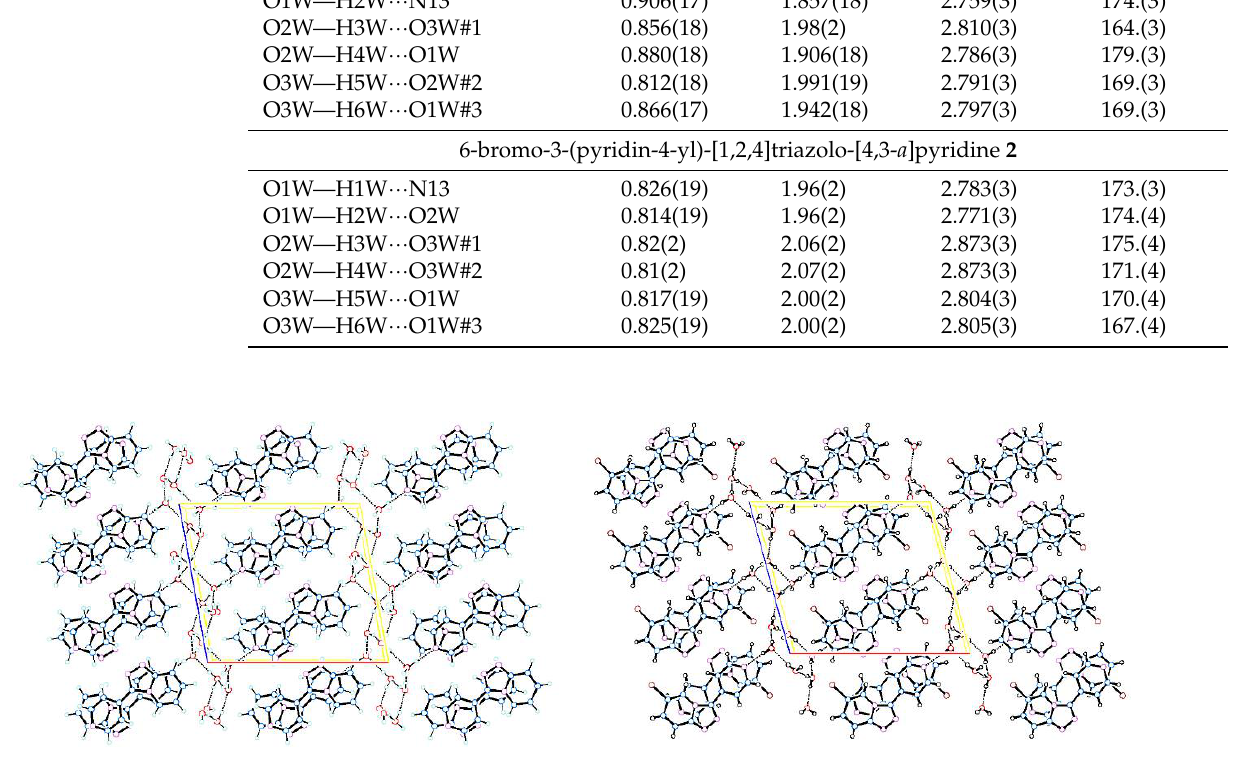
Figure 2. Crystal structure and hydrogen bonds for ( a ) 3-(pyridin-4-yl)-[1,2,4]triazolo[4,3- a ]pyridine 1 ; ( b ) 6-bromo-3-(pyridin-4-yl)-[1,2,4]triazolo-[4,3- a ]pyridine 2 .